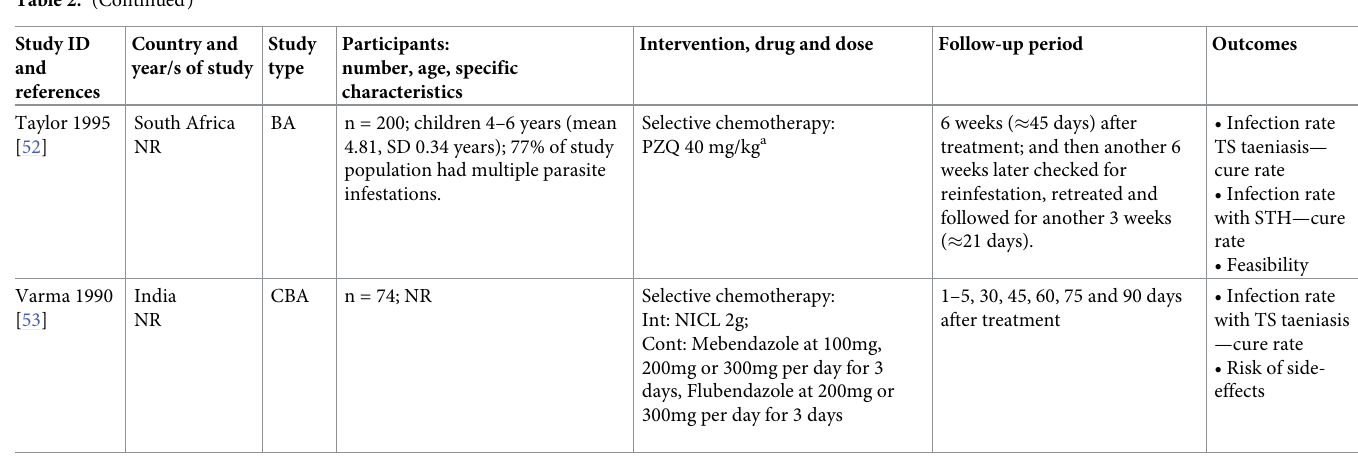
89%), suggesting that the pooled cure rate is probably not a robust estimate. The Doi plot (Panel A in S2 Fig) showed only minor asymmetry (LFK index -1.30), suggesting that publica- tion bias is not an issue.